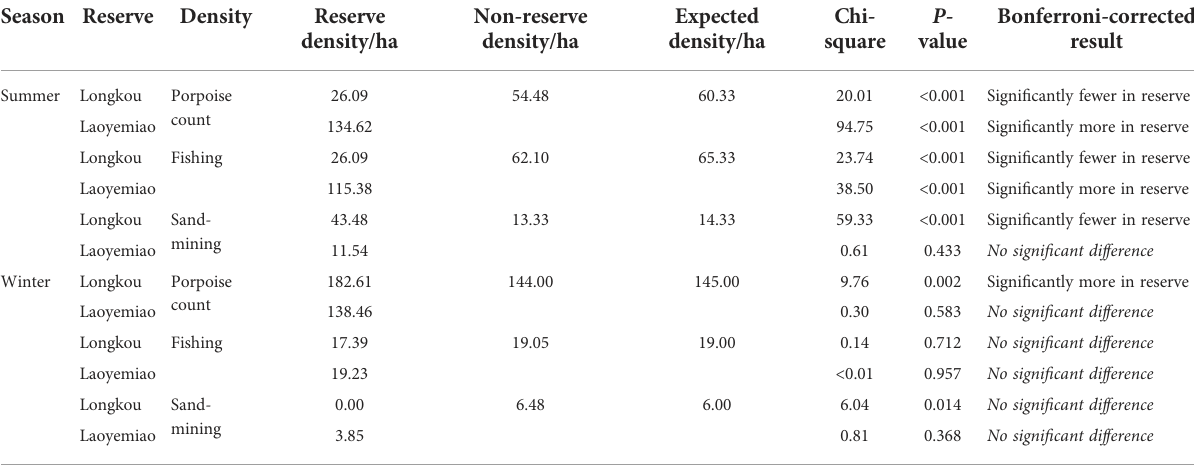
TABLE 2 Chi-squared tests for signi fi cant differences between porpoise, fi shing vessel, and sand-mining vessel densities inside and outside Poyang Lake reserves, in contrast with expected uniform density across survey area. Season Reserve